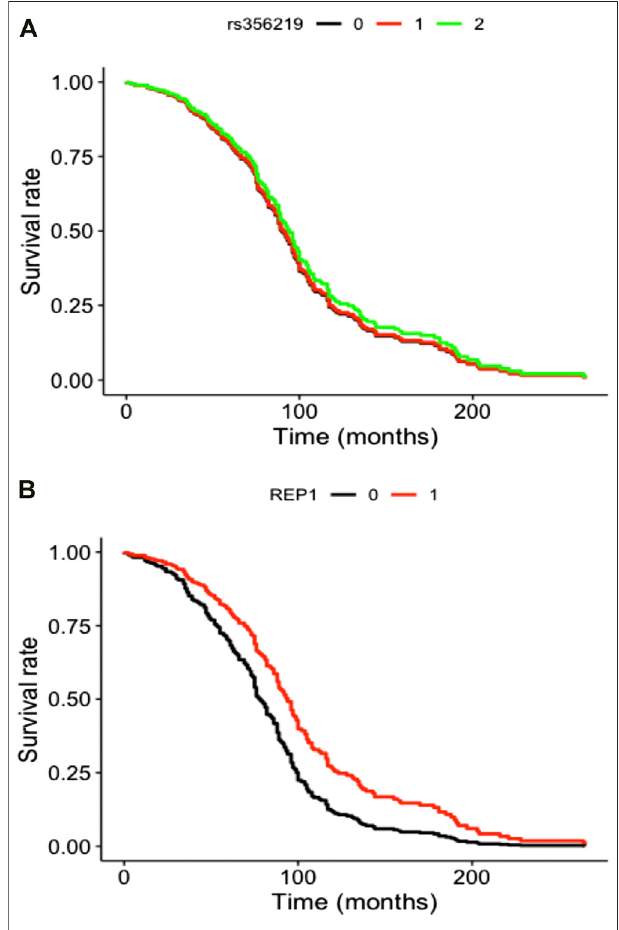
FIGURE 1 | Cox curves of genetic model tested modeling incident LID risk vs (A) additive genetic model of rs356219 and vs (B) pseudo-recessive genetic model of D4S8134. Genotype classes were de fi ned as (A) AA (black), AG (red) and GG (green) genotypes for rs356219 and (B) 263 bp allele carriers (black) vs all other genotypes (red) for